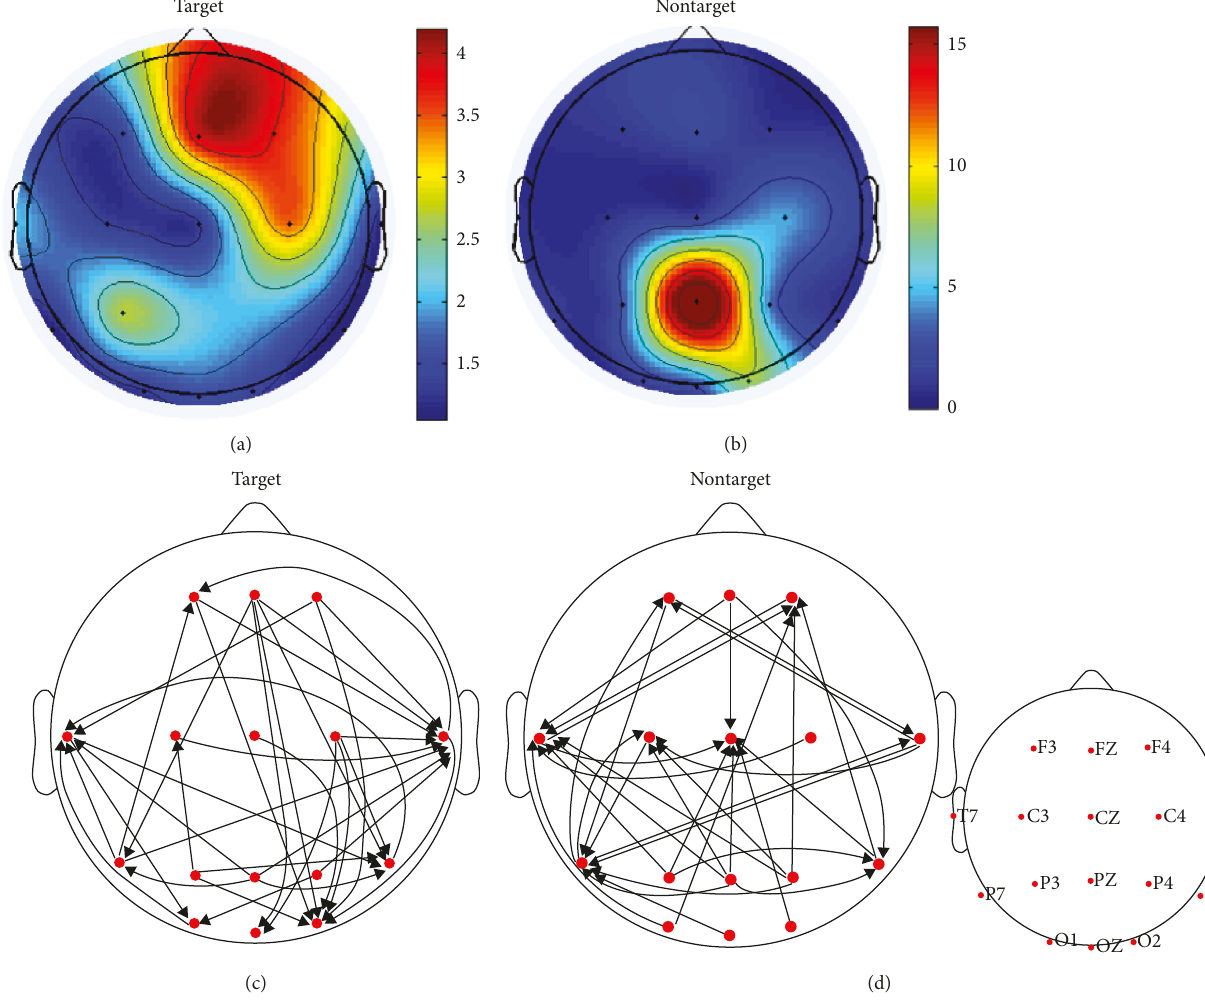
Figure 3: Flow gain mappings averaged over all subjects in response to target (a) and nontarget (b). Group average e ff ective connection patterns of target (c) and nontarget (d) condition. The arrows stand for information fl ow direction. For better illustration purpose, only the top 15% of the maximum edges are